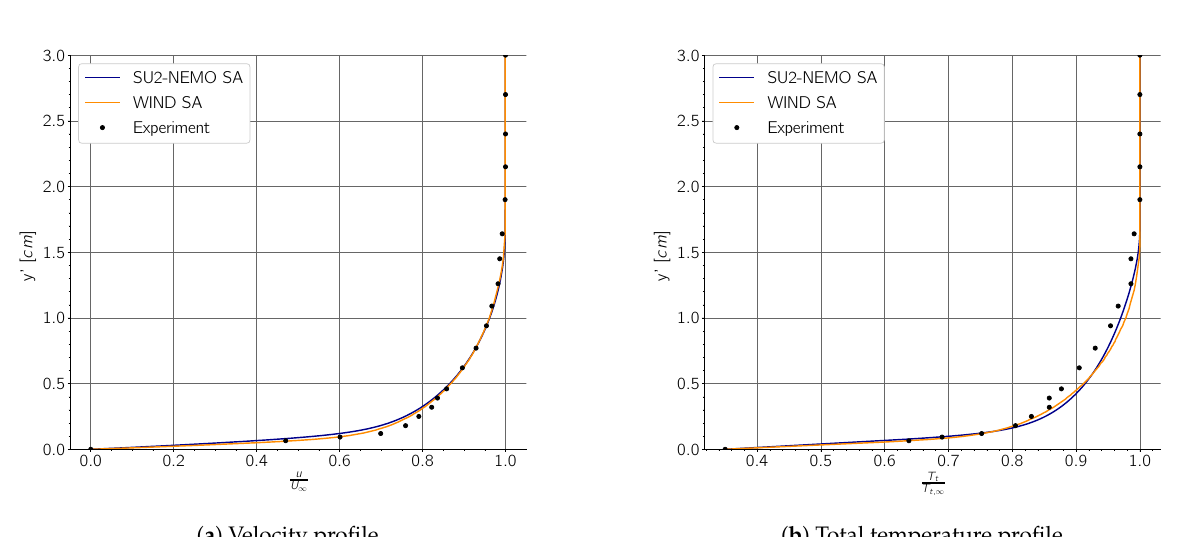
( a ) Velocity profile. ( b ) Total temperature profile. Figure 12. Boundary layer profile 6 cm before the compression corner. Comparison with experimental [53] and numeri- cal [54]